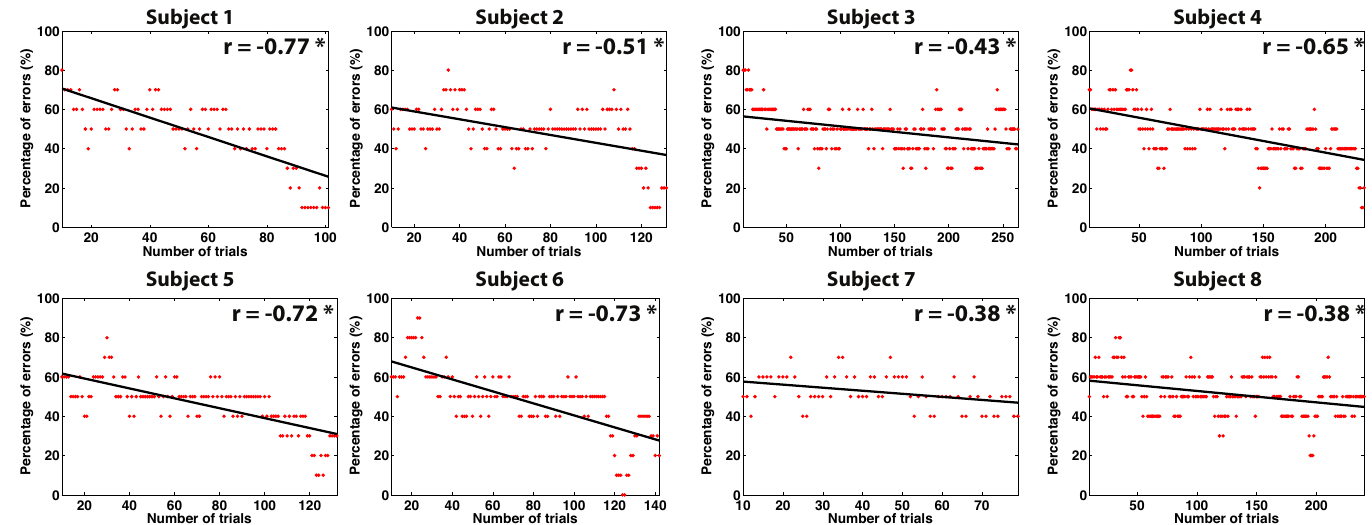
Fig 3. Percentage of errors performed by the device during the last 10 trials, as a function of the number of trials (only during the first target). Additionally, the tendency line and the correlation value are also